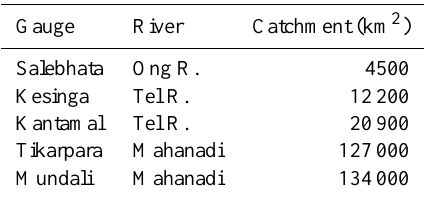
Table 5. Analysed stream gauges in the central parts of the Ma- hanadi Basin (see Fig.